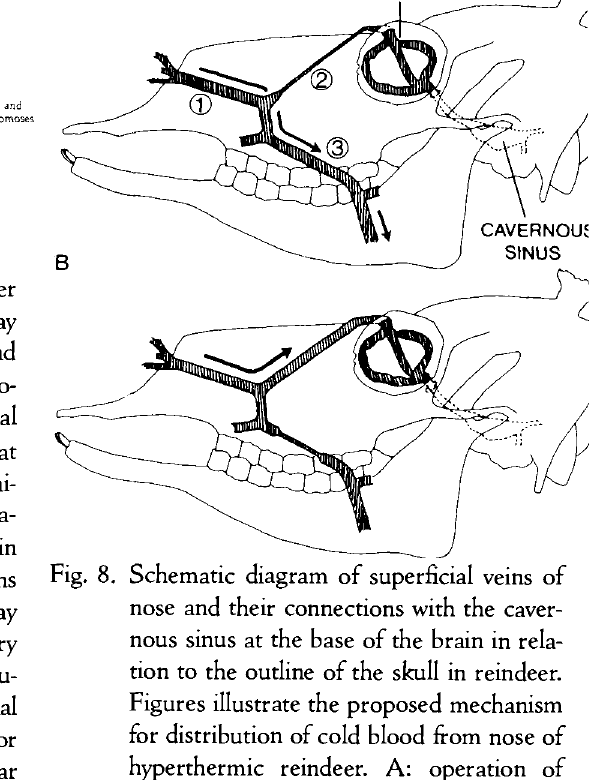
Fig. 7. Arterial and venous vasculature of reindeer nose. During heat conservation, blood may run countercurrent in the two retia and leave the nasal mucosa through the spheno palatine group of veins (14), with the dorsal nasal vein (7) constricted. During heat dissipation, however, blood may run uni- directionally in both retia and leave the na sal mucosa by way of the dorsal nasal vein (7), and the sphenopalatine group of veins (14) would now be constricted. In this way heat dissipation by way of the respiratory tract is optimized, and cooled venous efflu ent may be directed, either via the facial vein (10) to the external jugular vein (15) for general body cooling or via the angular oculi veins (8) to the opthalmic plexus (16) and the cavernous sinus (17) for selective cooling of arterial blood to the brain. 1, common carotid a.; 2, arterial supply to carotid rete; 3, arterial supply to orbital rete; 4, sphenopalatine a. with its branches; 5, infraorbital a.; 6, circle of Willis; 7, dor sal nasal v.;8, angular oculi v.; 9, maxillary labial v.; 10, facial v.; 11, deep facial v.; 12, maxillary v.; 13, infraorbital v.; 14, spheno palatine group of veins; 15, external jugular v.; 16, ophthalmic venous plexus with orbi tal rete (dashed lines); 17, carvernous sinus with carotid rete (dashed lines) (from John- sen, Blix, et ai, 1985).